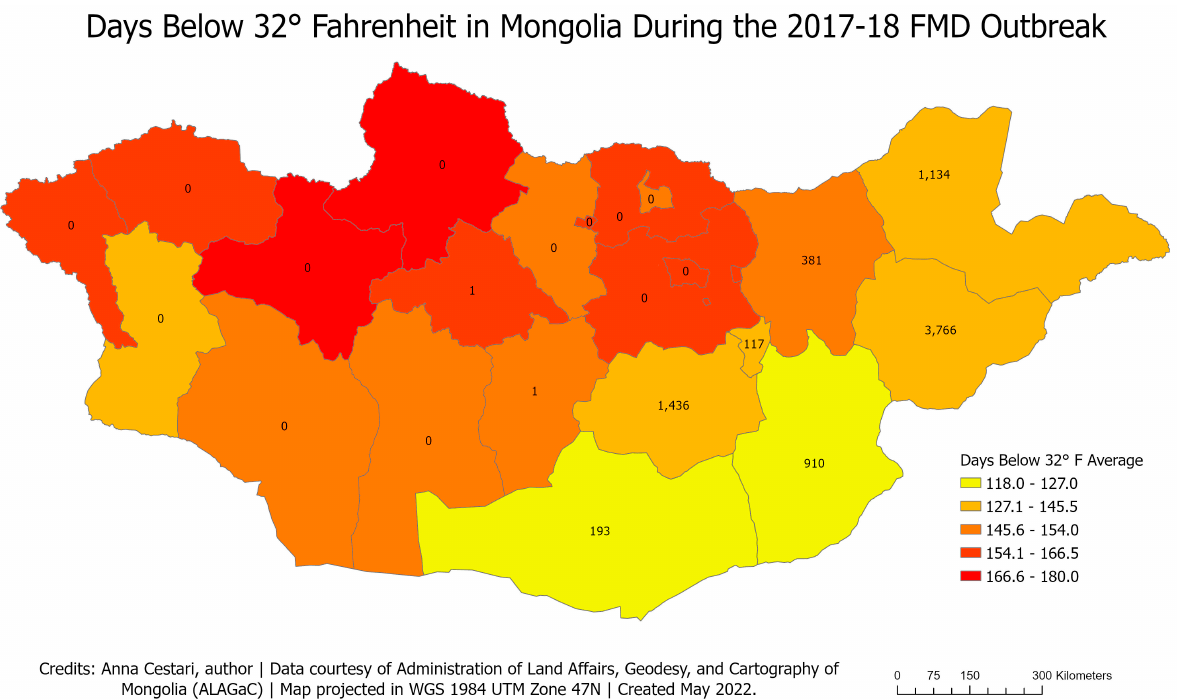
Figure 7. This map shows the provinces in Mongolia with the color shading based on the number of days with temperature below 32 °F. The darker colors represent more days below 32 °F. Each province is labeled with its number of foot and mouth disease cases for the 2017–2018 outbreak.